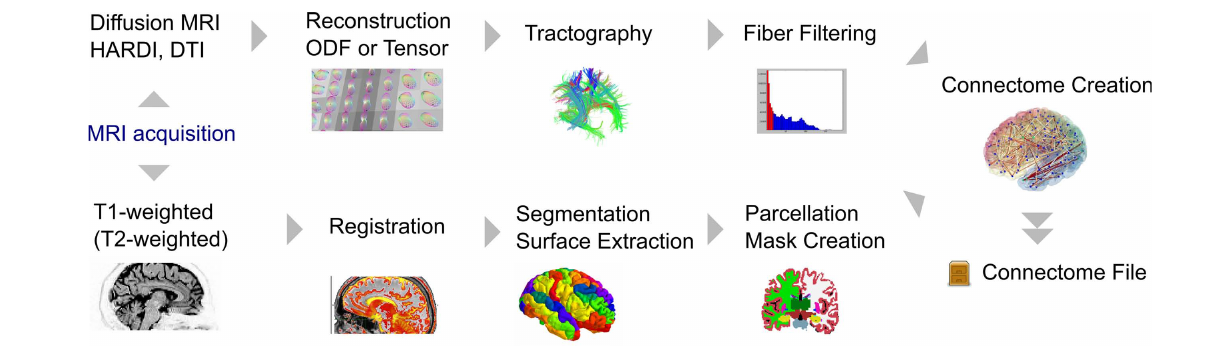
Figure 5 | The general processing stages of the Connectome Mapper. This pipeline is an example implementation of a structural connectome mapping stream. Here, two processing streams dealing separately with brain region (node) and white matter (edge) information eventually converge into the connectome of one particular